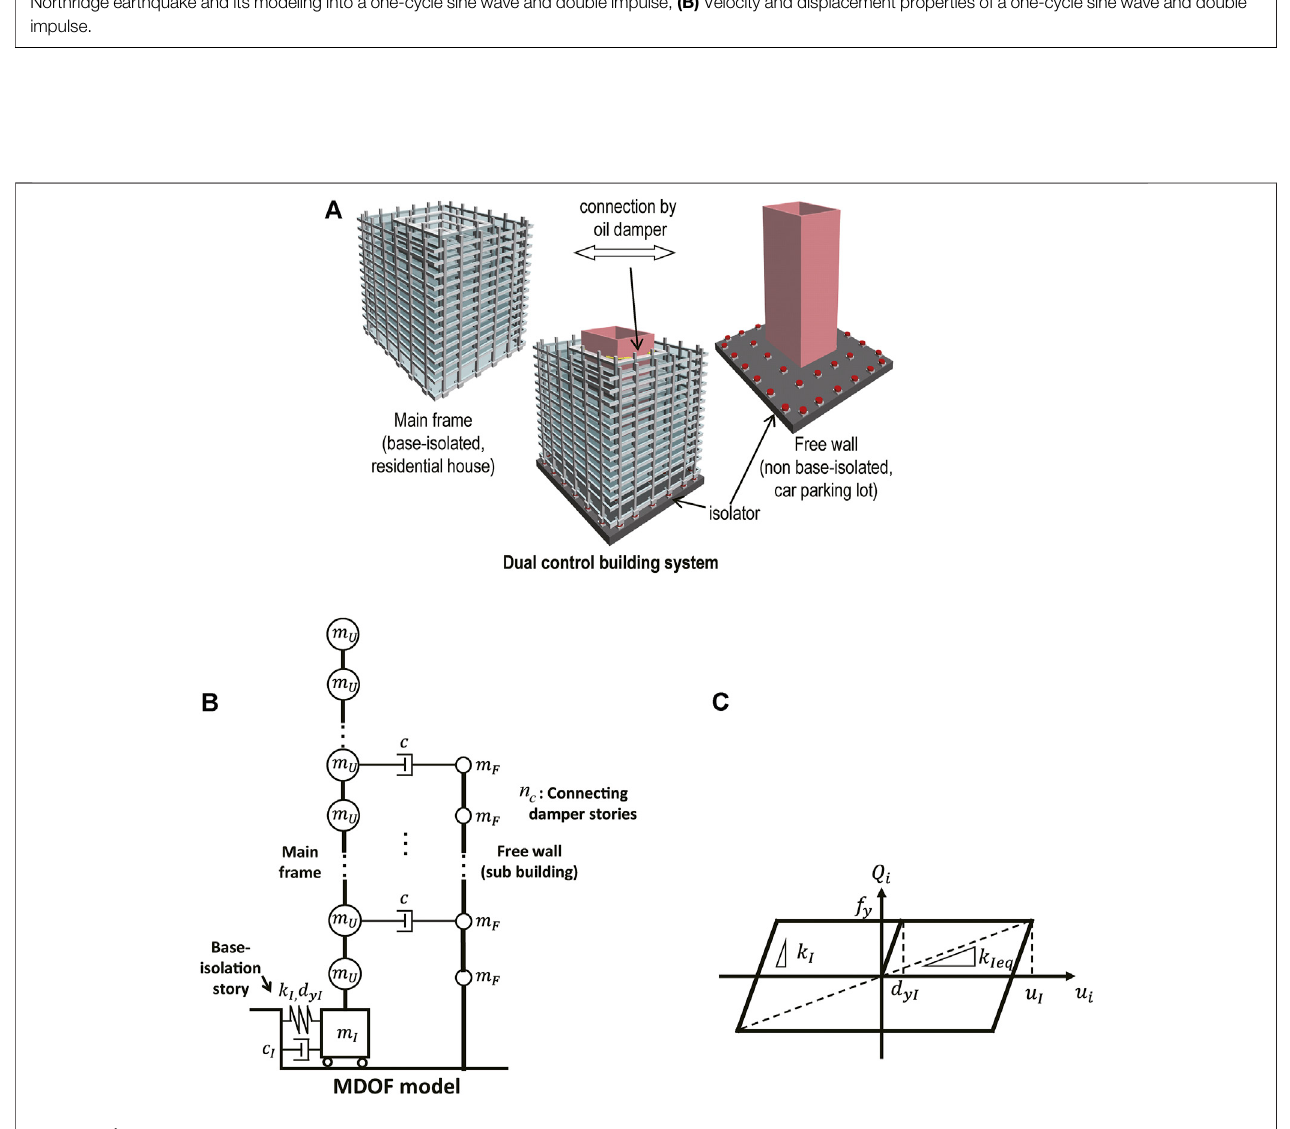
FIGURE 2 | Base-isolation, building-connection hybrid control system, (A) Overview of system (Fukumoto and Takewaki, 2017), (B) MDOF shear building model with the base-isolation, building-connection hybrid control system, (C) Restoring force-deformation relation of the base-isolation story.